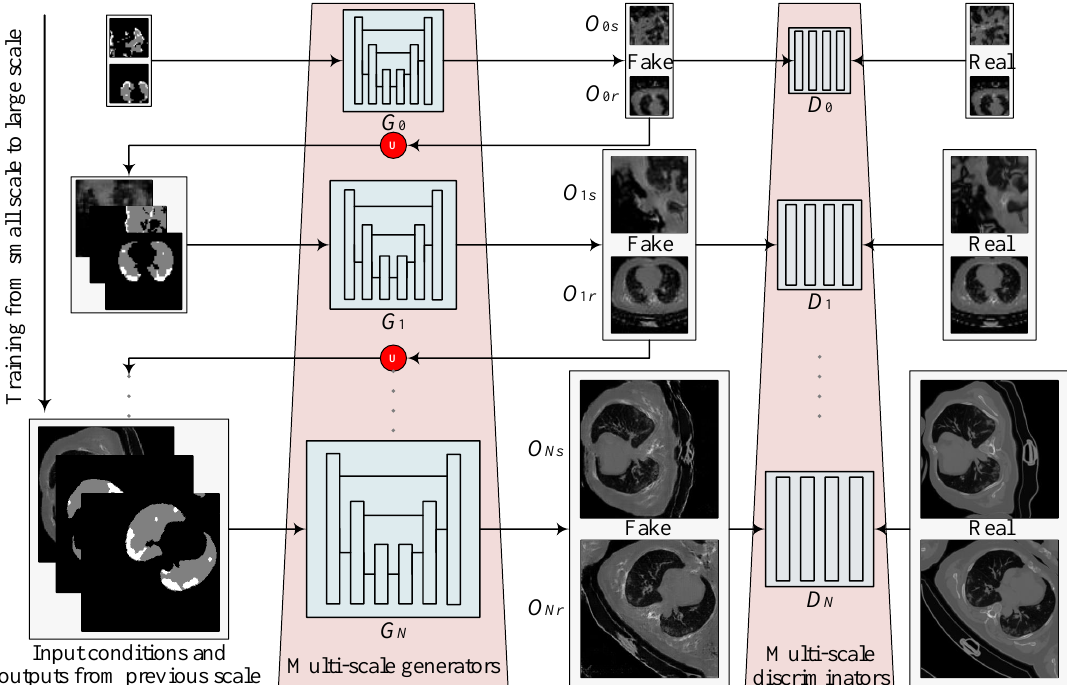
Figure 2. Multi-scale architecture of proposed CoSinGAN. CoSinGAN consists of a pyramid of GANs, each of which has a two-stage generator and is responsible for translating condition mask into radiological image at a different scale. The input to G i is an augmented condition mask and the synthetic radiological image from the scale i − 1 that is upsampled to the scale i (except for scale 0). By iterating optimizations from small image scale to large image scale, CoSinGAN progressively learns to generate realistic and high-resolution (512 × 512) radiological images that match the input condition masks precisely. The notation U represents an upsampling operation. The white and gray in the condition masks represent the infected regions and lungs,